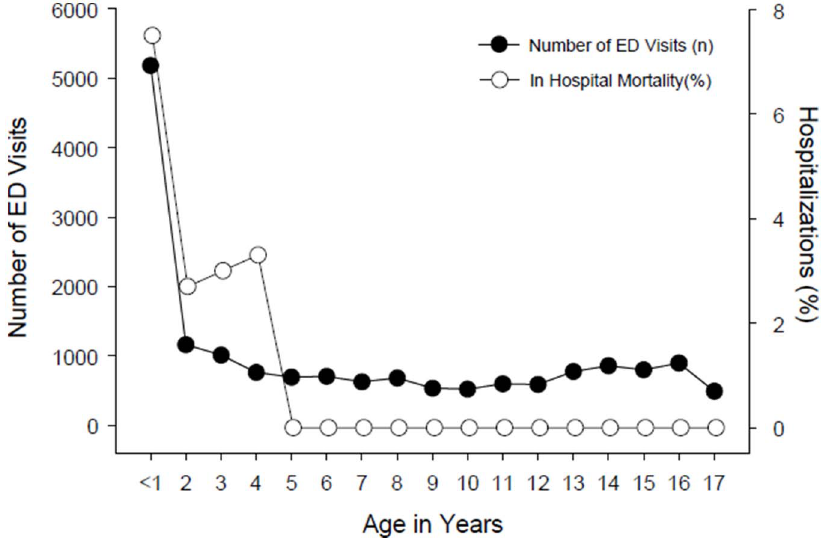
Figure 3. Effect of age on ED visits and in-hospital mortality. ED visits represented by left y axis and in-hospital mortality (%) by right y axis.